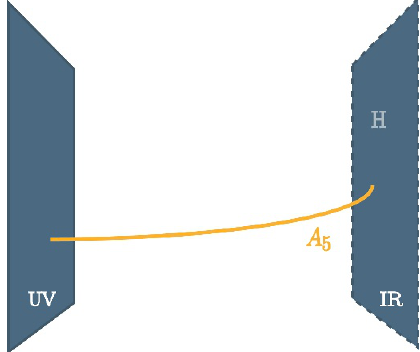
Figure 2 . Sketch of a slice of AdS 5 space which is bounded by two branes. We identify the relaxion with the 5th component of a U(1) gauge (cid:12)eld in the bulk. Its wavefunction is then localized towards the IR brane. The Higgs is localized on (or near) the IR brane. The UV brane corresponds to the Planck scale. We draw the IR brane with a dashed contour as a reminder that the IR scale in our model can be much larger than the usual TeV scale of the Randall-Sundrum